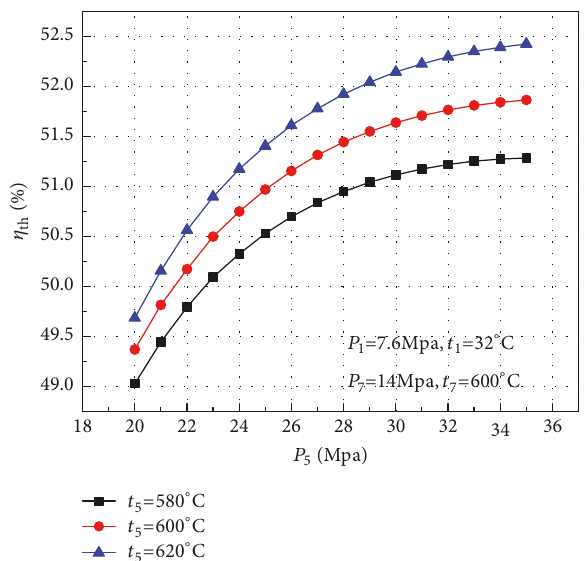
Figure 9: Effects of LPT inlet pressure on cycle efficiency at different HPT inlet pressure.